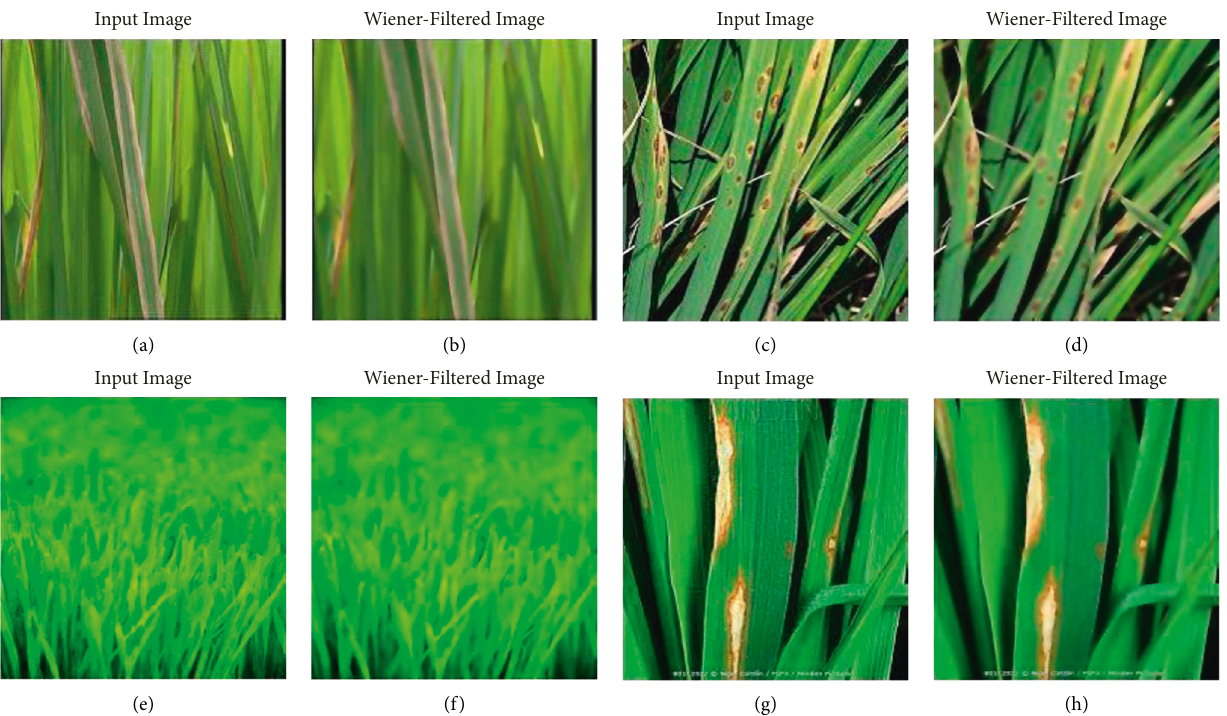
Figure 10: Wiener filter results from different rice plant diseases. (a) Input image of bacterial leaf blight. (b) Result obtained from the Wiener filter. (c) Input image of brown spot. (d) Result obtained from the Wiener filter. (e) Input image of healthy leaf. (f) Result obtained from the Wiener filter. (g) Input image of rice blast. (h) Result obtained from the Wiener